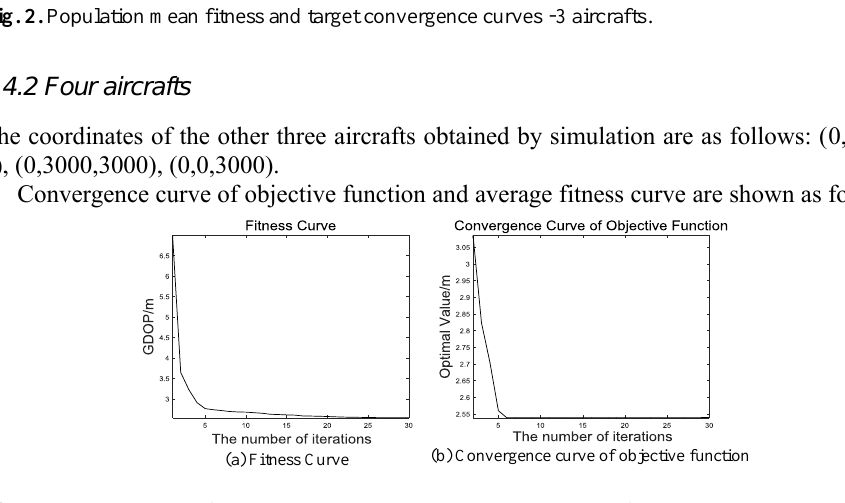
Fig. 3. Population mean fitness and target convergence curves -4